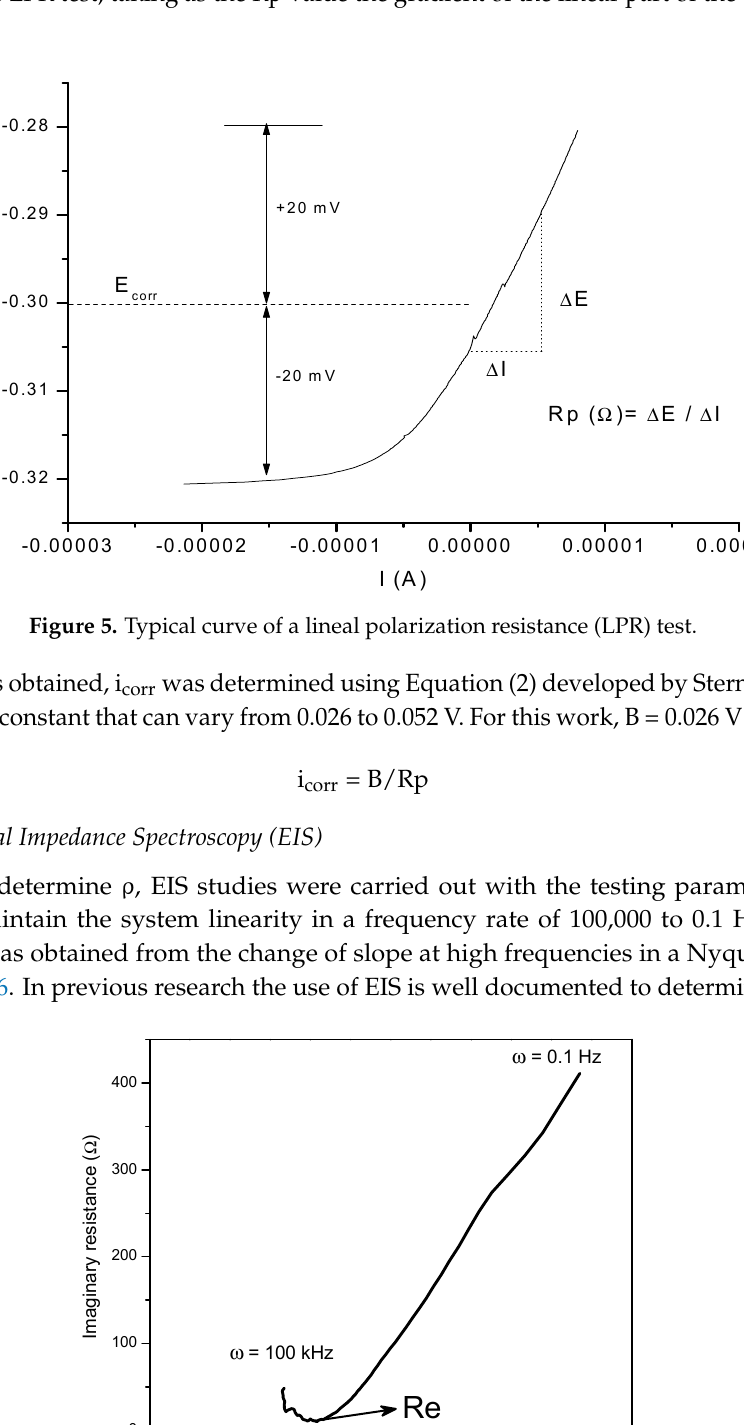
Figure 4. Experimental arrangement for the electrochemical tests. AE: auxiliary electrode; WE: working electrode; RE: reference electrode.